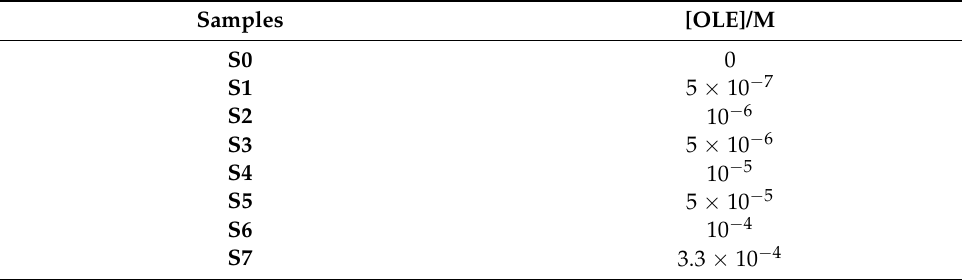
Table 1. Sample nomenclature and oleuropein